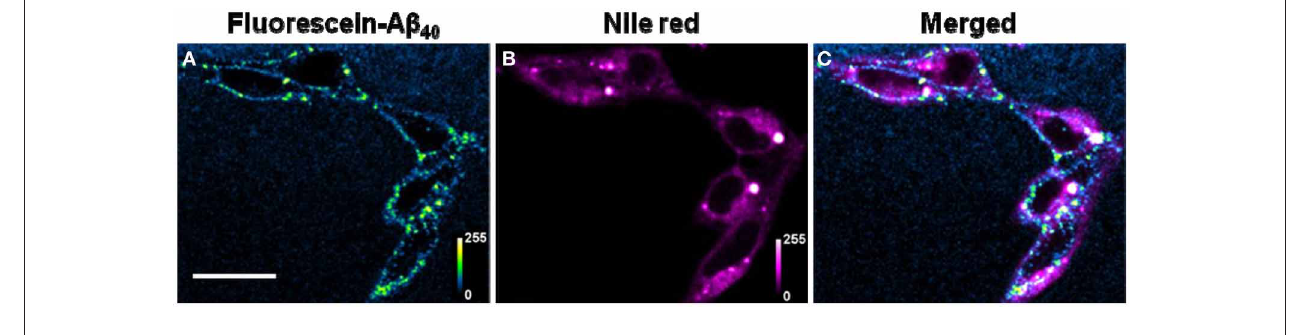
FIGURE A3 | Location of A β aggregates. Confocal image of (A) RN46A cells treated with 50nM of oligomeric F-A β 40 for 30min, (B) same cells incubated with 300nM Nile red